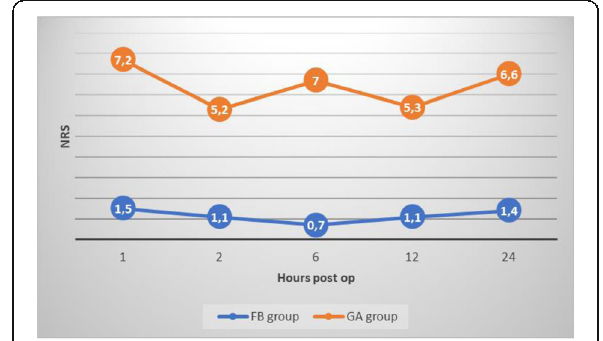
Fig. 1 (abstract A35). See text for description